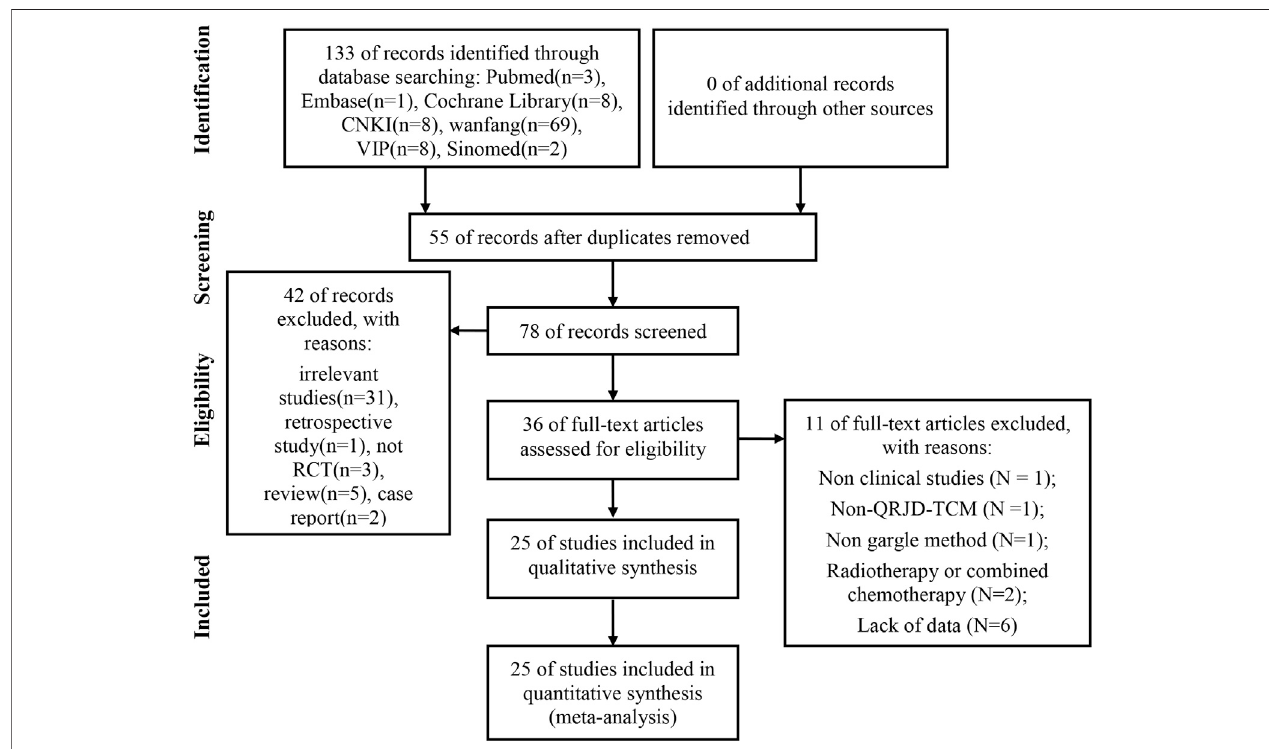
FIGURE 1 | Flow chart of study identi fi cation and